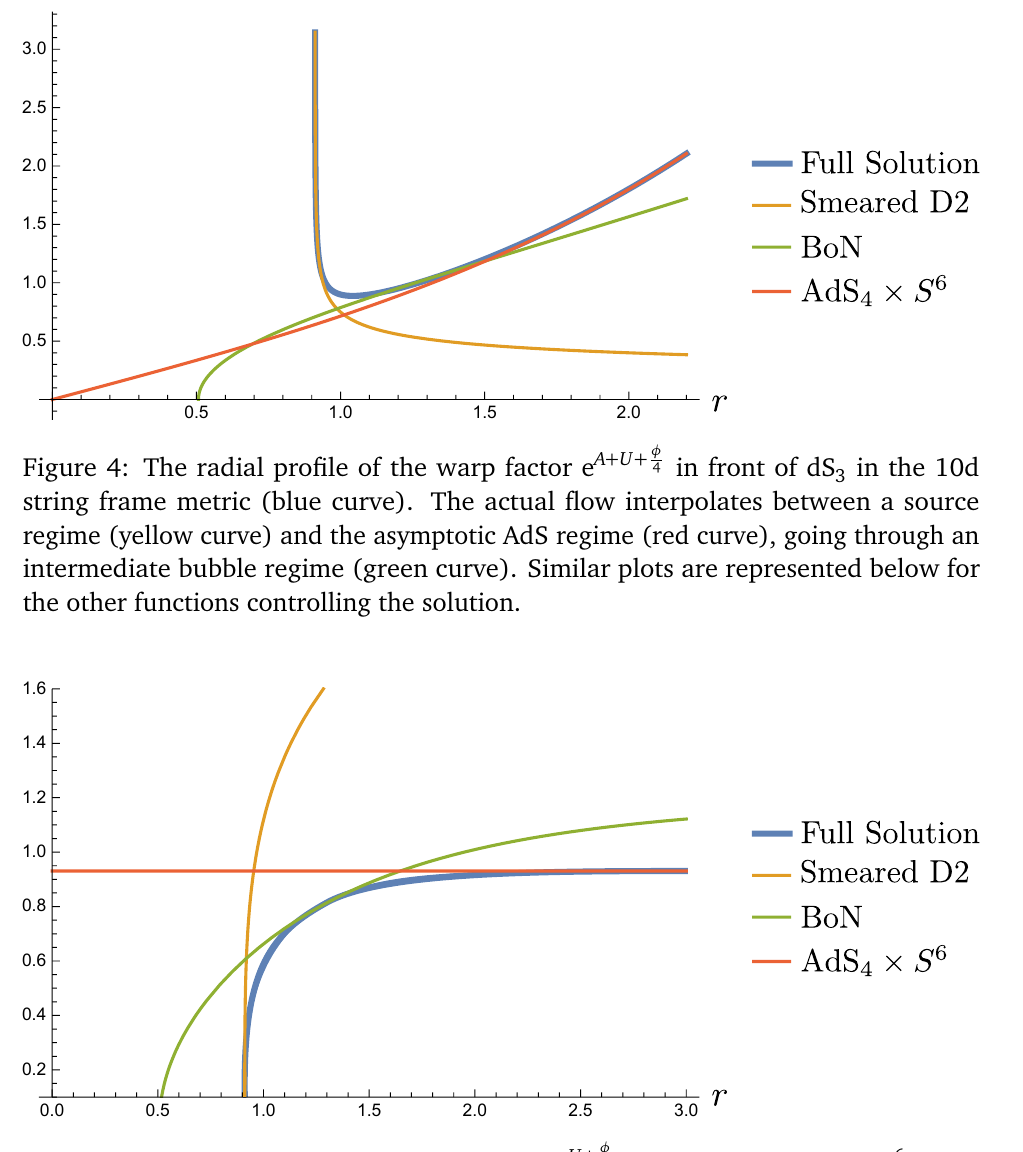
Figure 5: The radial profile of the warp factor e U + 10d string frame